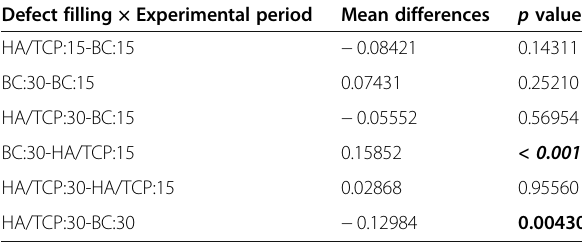
Table 2 Multiple comparison of trabecular separation Defect filling × Experimental period Mean differences p